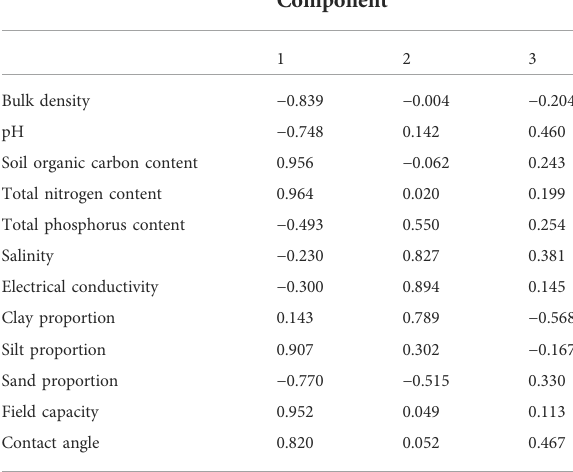
TABLE 4 Component matrix shows the correlation coef fi cients and variance value of three principal components with soil